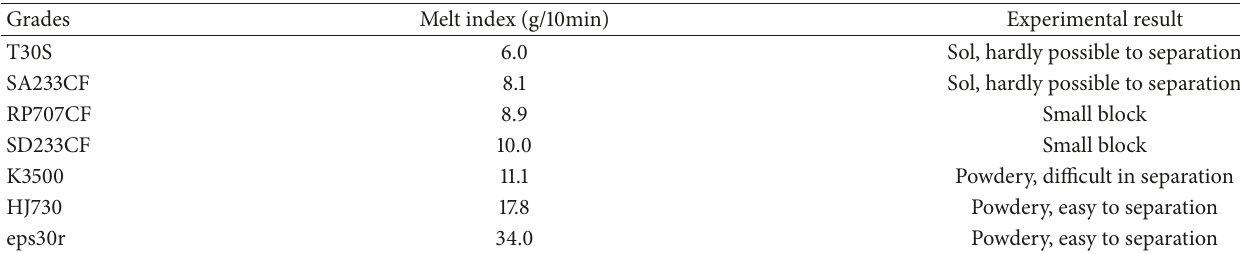
Table 1: The effects of MFR of PP on preparation of